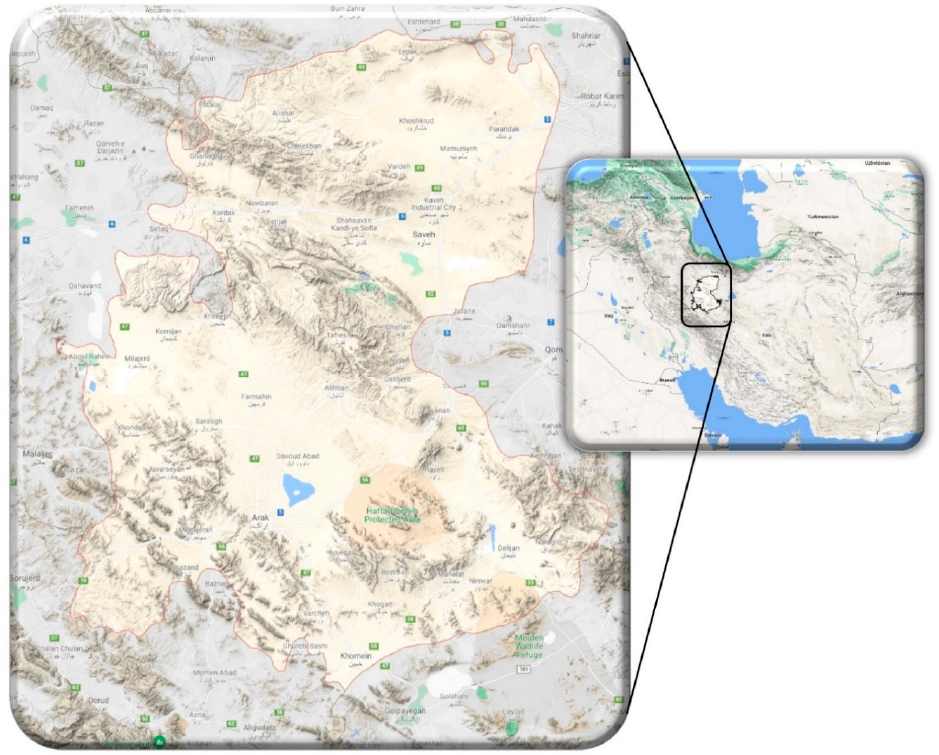
Figure 1. Geography and location of Markazi province in Iran; maps sourced from Google Earth [61].